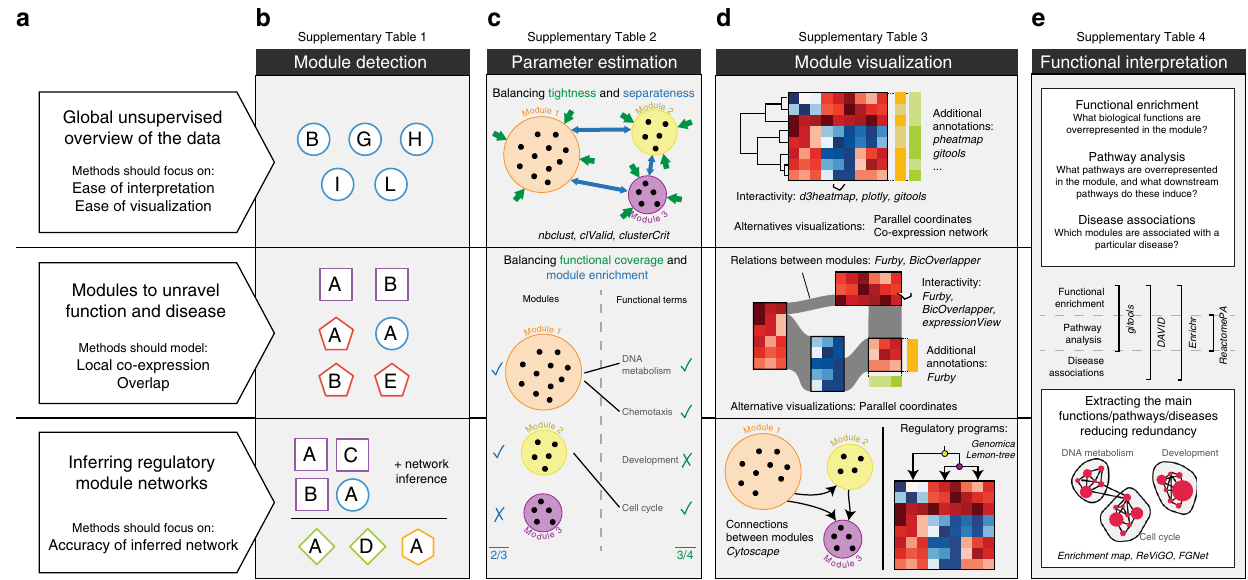
Fig. 5 Practical guidelines for module detection in gene expression data. Module detection in gene expression data has three main applications (left; panel a ). For each application, we suggest different module detection methods ( b ), which in turn in fl uences the way parameters are estimated ( c ), how the modules can be visualized ( d ), and how they can be functionally interpreted ( e